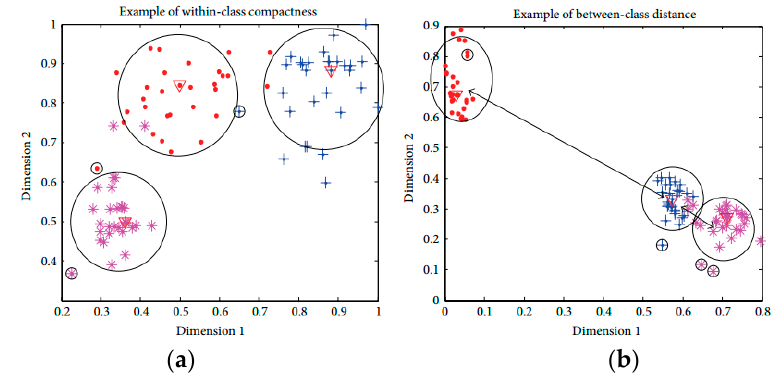
Figure 3. Examples of exceptions in feature distribution. ( a ) Classes are well-separated; ( b ) Classes are overlapped.